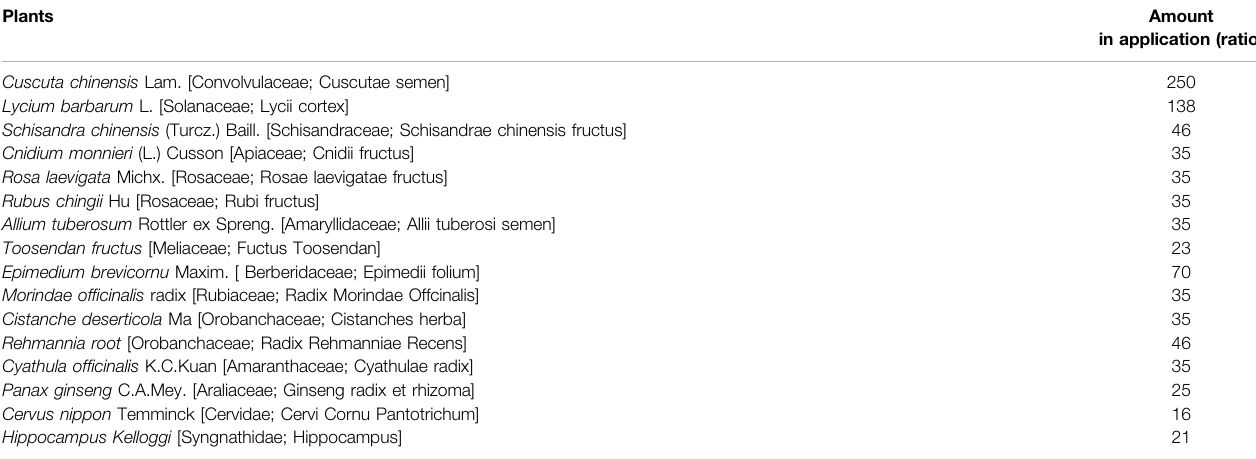
TABLE 1 | The ratio of the plants present in the preparation of BZBS. Plants Amount